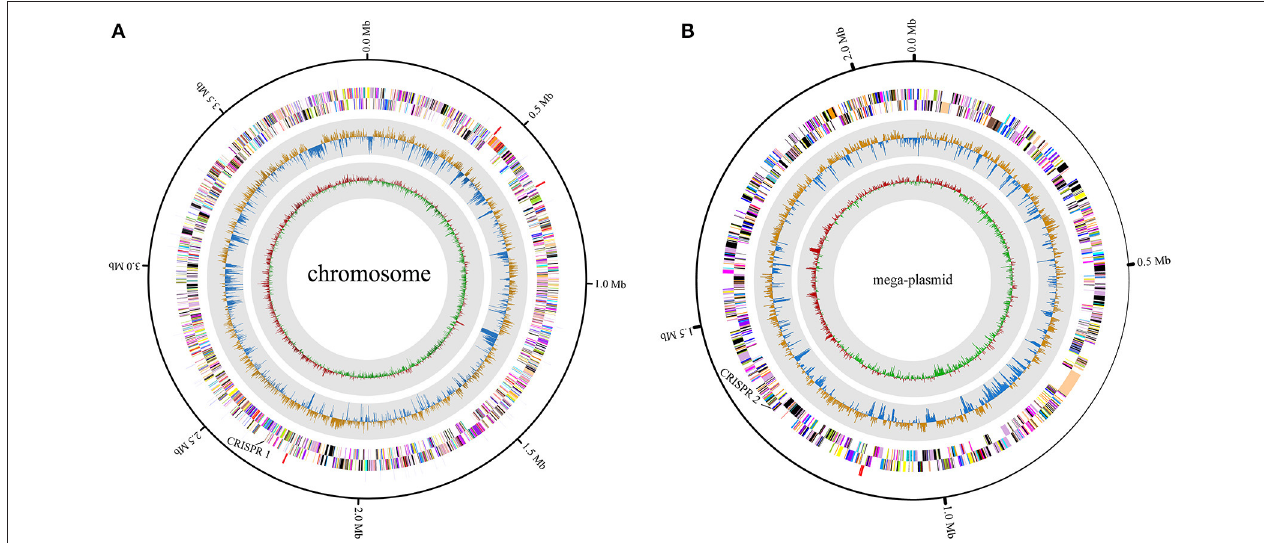
FIGURE 1 | Circular map of R. solanacearum strain EP1 genome. (A) chromosome; (B) mega-plasmid. The distribution of the circle from outer to inner indicates rRNA and tRNA, reverse CDS, forward CDS, GC skew, and GC ratio.